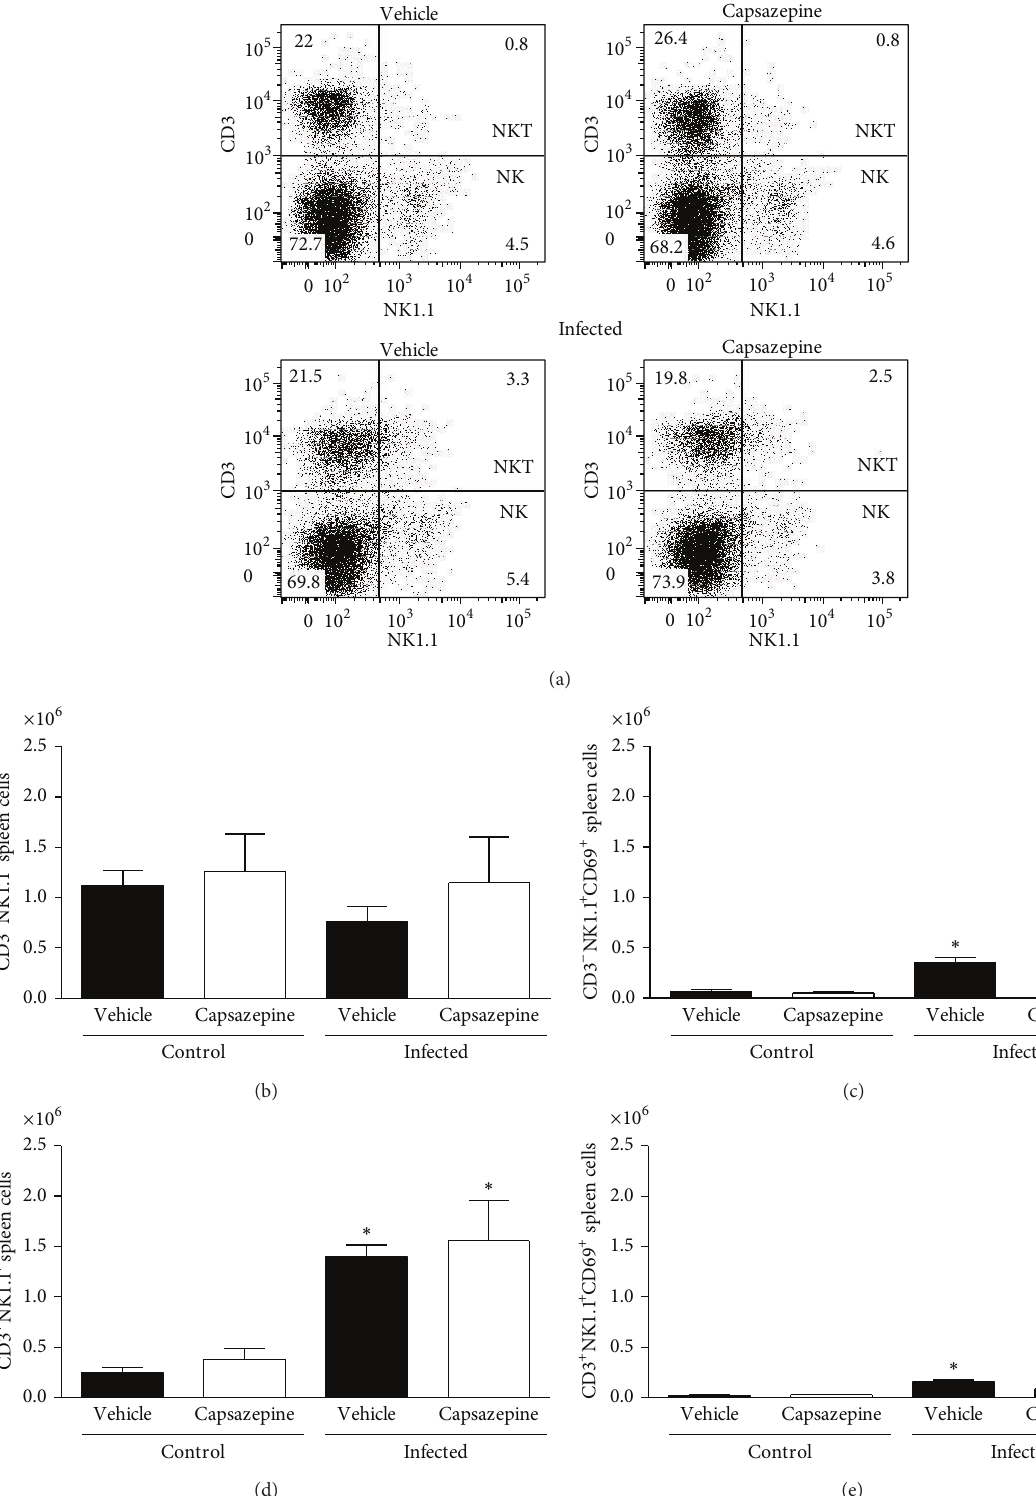
Figure 5: Effect of capsazepine on spleen CD3 − NK1.1 + and CD3 + NK1.1 + cells. (a) Representative two-colour dot-plots for spleen CD3 − NK1.1 +